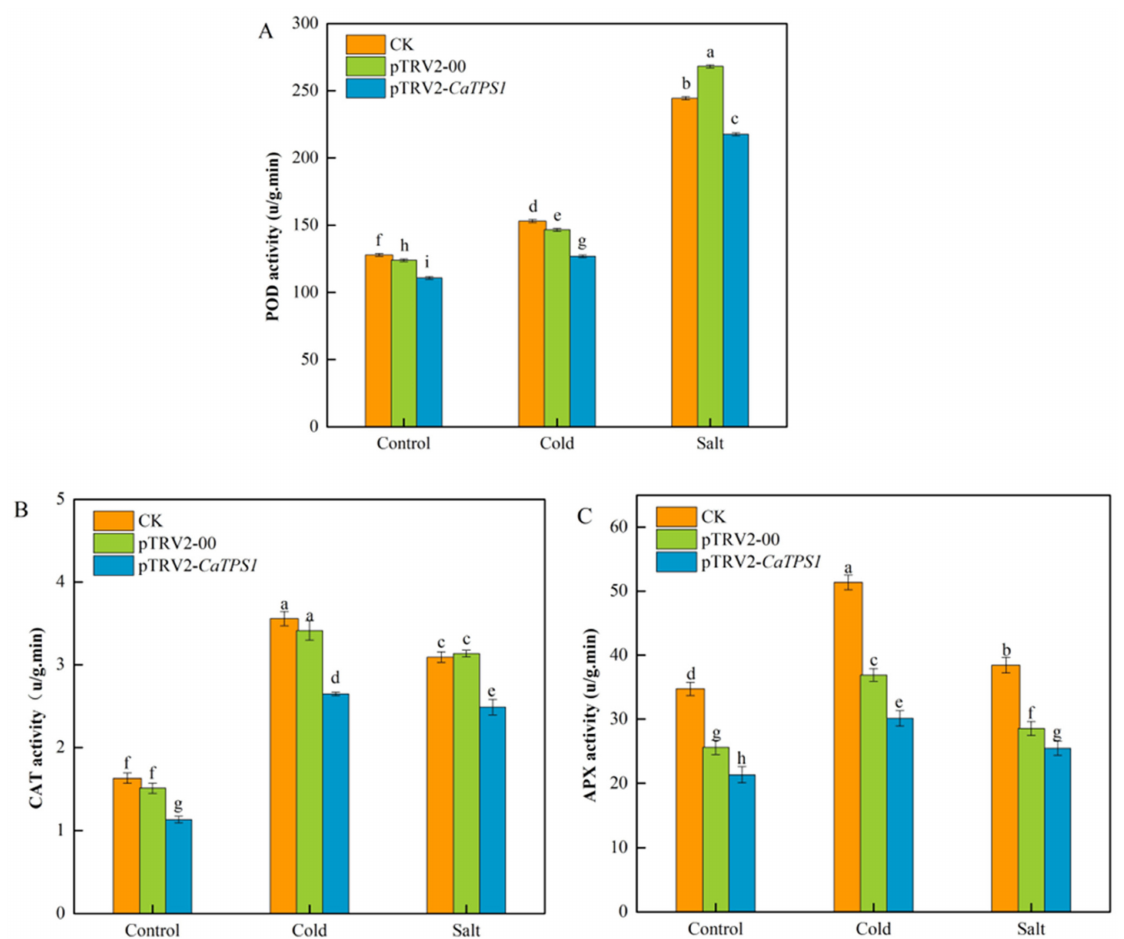
Figure 7. The antioxidant enzymes under cold and salt stresses. POD activity ( A ), CAT activity ( B ), and APX activity ( C ) of CK, pTRV2-00, and pTRV2- CaTPS1 . Each value is shown as the mean ±